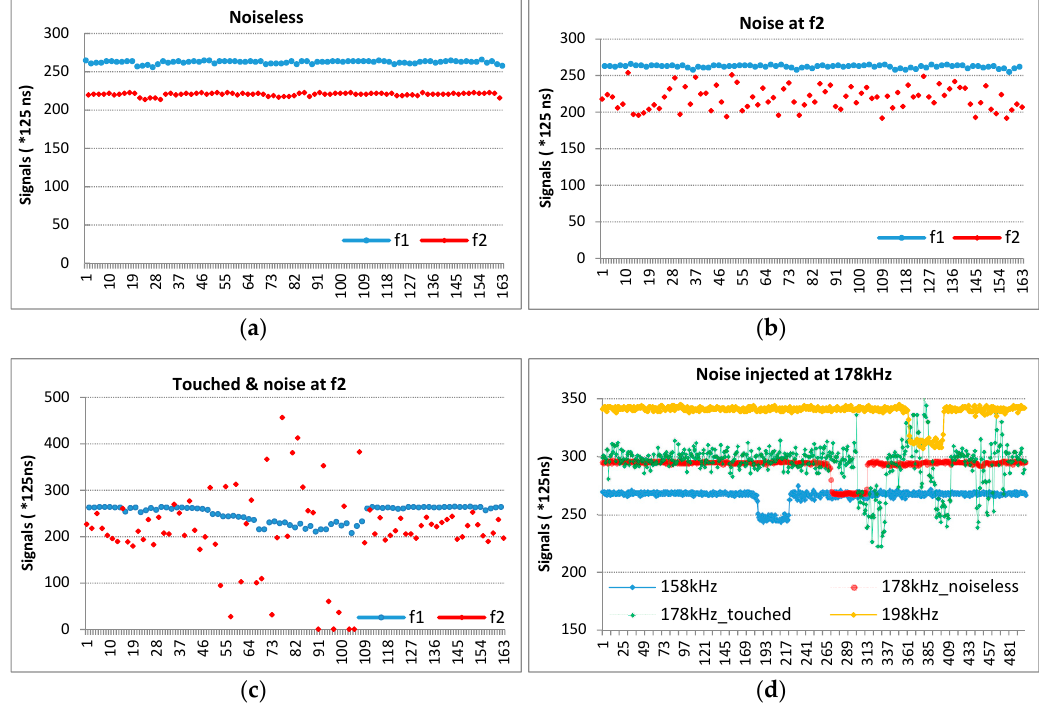
Figure 8. The effect of injected noise on the mutual-capacitance sensor; ( a ) the noiseless frequencies; ( b ) the injected noise at f 2 frequency; ( c ) touching on a sensor while injecting noise at f 2 frequency; ( d ) while injecting noise at 178kHz, channel-6 is driven by the carrier at 158 kHz, 178 kHz and 198 kHz respectively.